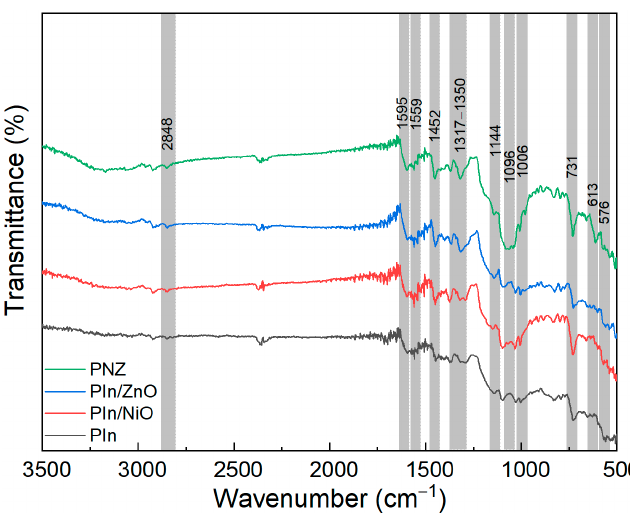
Figure 2. FTIR spectra of the synthesized PIn and its metal oxide composites. Characteristic deformation vibrations for PIn are found at 2848 cm − 1 (aromatic C-H), 1595 cm − 1 (C-C), 1559 cm − 1 (N-H), 1452 cm − 1 and 1144 cm − 1 (C-N), 1045 cm − 1 (benzene ring), and 731 cm − 1 (C-H). The pyrrole ring stretching vibration is at 1317–1350 cm − 1 . The features at 1006 cm − 1 and 576 cm − 1 are attributed to S=O and SO 31 − vibrations of DBSA and H 2 SO 4 . The incorporation of NiO and ZnO into the PIn structure is also observed; additional low-intensity bands at 613 cm − 1 and 507 cm − 1 for Ni-O and Zn-O,